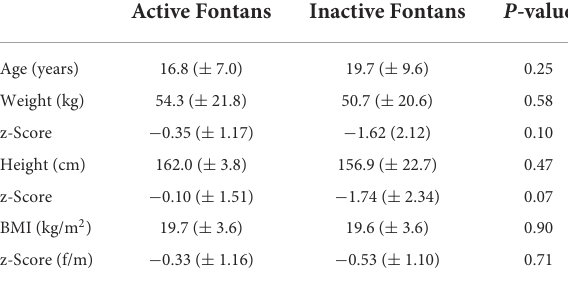
Table 4. There were no significant differences between the two groups with respect to aortic/neoaortic regurgitation, AV-valve regurgitation or EF (Figure 1). Furthermore, the number of patients with a low ejection fraction (EF < 40%) was comparable between the two groups (four patients in the active group and two patients in the inactive group). Only one patient in the group of active Fontan patients and two in the group of inactive